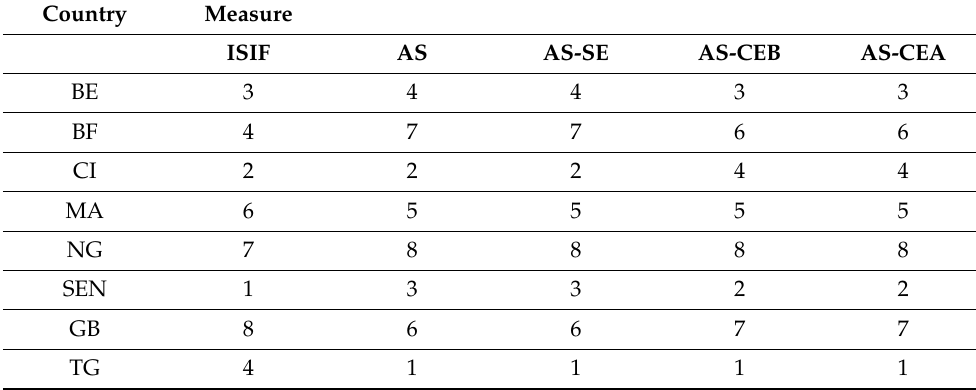
Table 14. Rank—Country—2017 measures. Country Measure